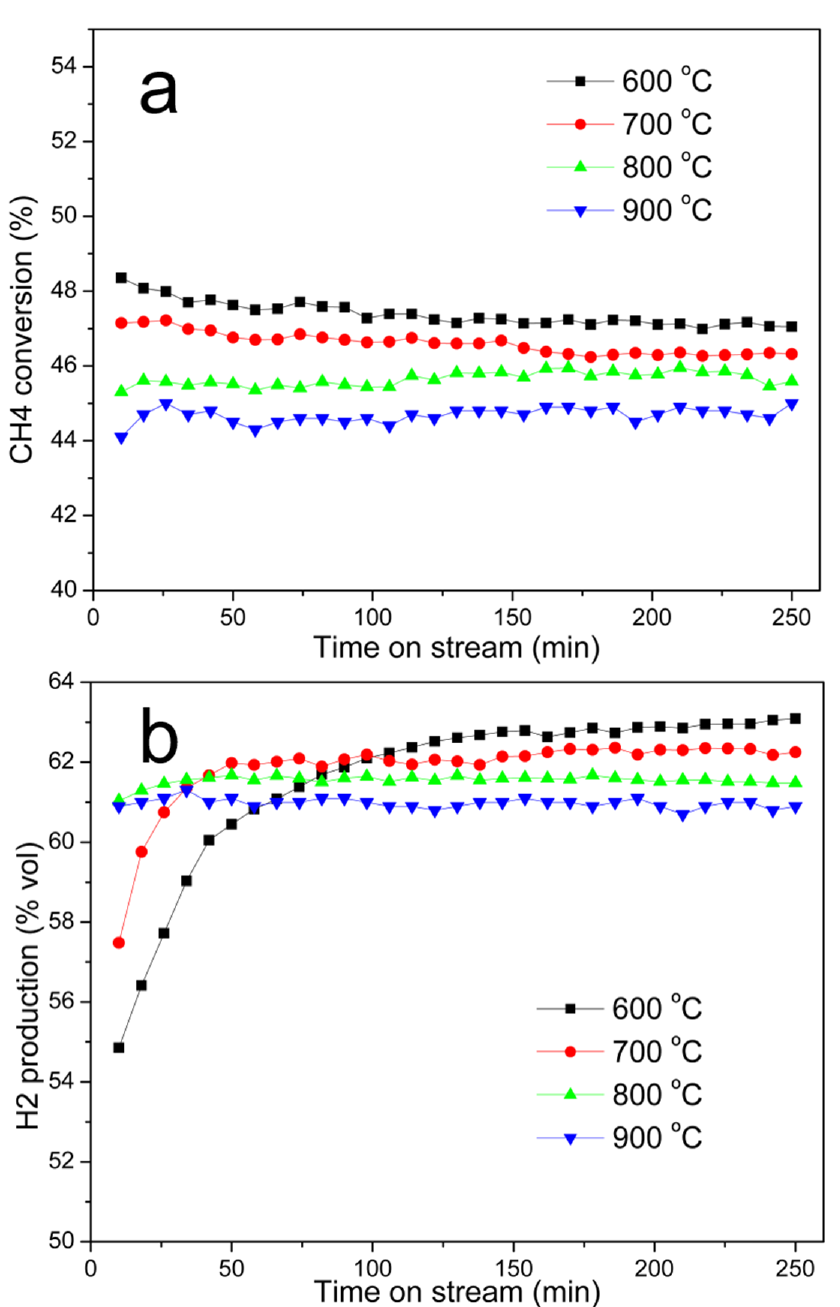
Figure 5. CH 4 conversion ( a ) and H 2 production ( b ) with Ni@G catalysts carbonized at different temperature: 10 g catalyst was loaded in the reactor, testing temperature: 800 °C; gas flow rate: 100 mL/min.